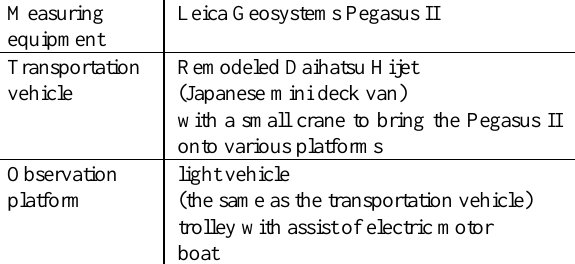
Table 2. Hardware configuration of the developed system